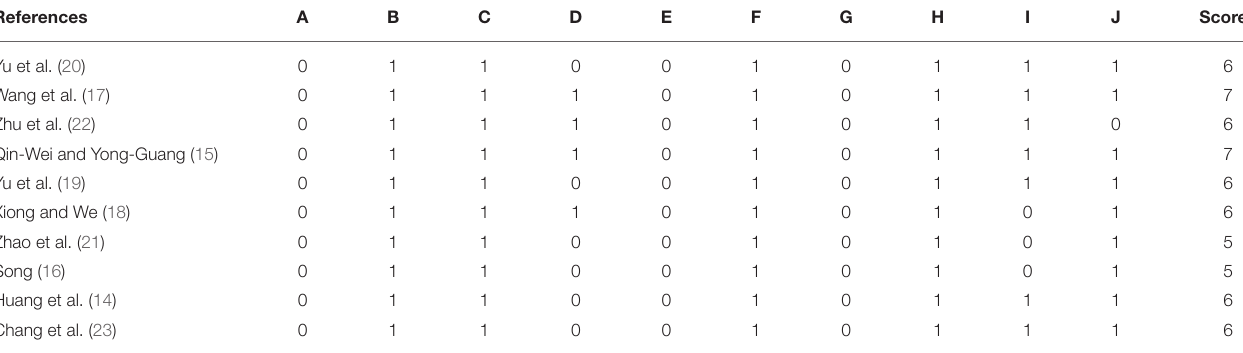
TABLE 2 | Quality assessment of included randomized controlled trials.